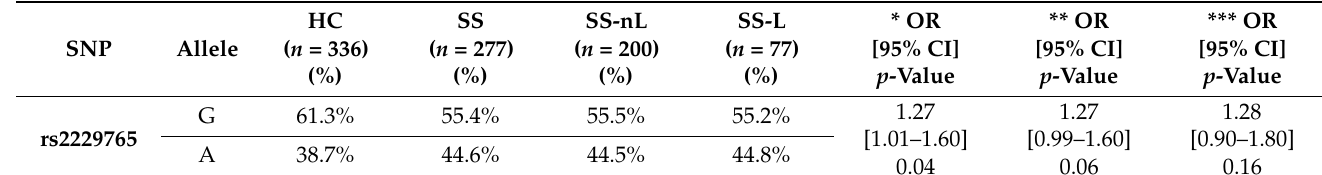
Table 1. Distribution of the allelic frequencies of the IGF1R rs2229765 variant in SS populations versus HCs.